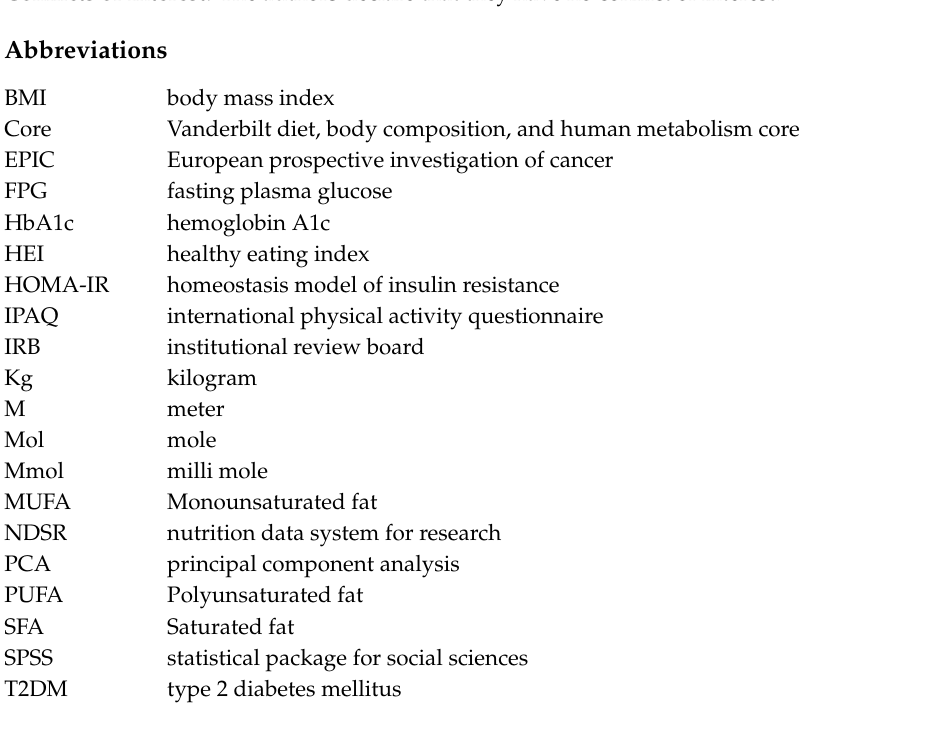
Table S1: The NDSR Output–Driven Food Groups ( n = 14) and their Component Food and Beverage Items ( n = 168) Used in Dietary Pattern Analysis. Figure S1: Results from Spearman Rank-Order Correlation Matrix with r ≥ 0.20 Confirming Positive Association Between Individual Food or Beverage Item and Primary Food